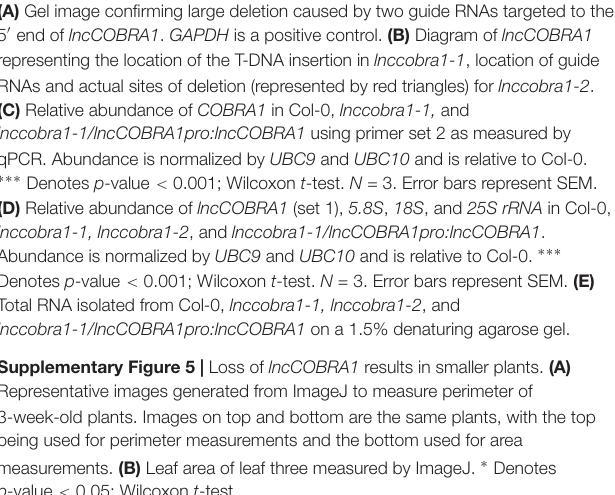
Supplementary Figure 1 | Identification of highly conserved, protein-bound lincRNAs in the nuclei from 10-day-old seedlings. (A) Flowchart diagram of identification of lncCOBRA transcripts from protein interaction profile sequencing (PIP-seq) in the nuclei from 10-day-old seedlings (Gosai et al., 2015). (B) Abundance of all lncCOBRA transcripts during germination. Abundance is relative to dry seed after harvest. Data was provided in Narsai et al. (2017). Asterisk denotes lincRNAs with snoRNAs annotated within them. Raw values are listed in Supplementary Data Set 3 . (C) eFP browser views of abundance of lncCOBRA1 , lncCOBRA3 , and lncCOBRA5 during germination (Klepikova et al., 2016). (D) Abundance of lncCOBRA1 early seedling development using primer set